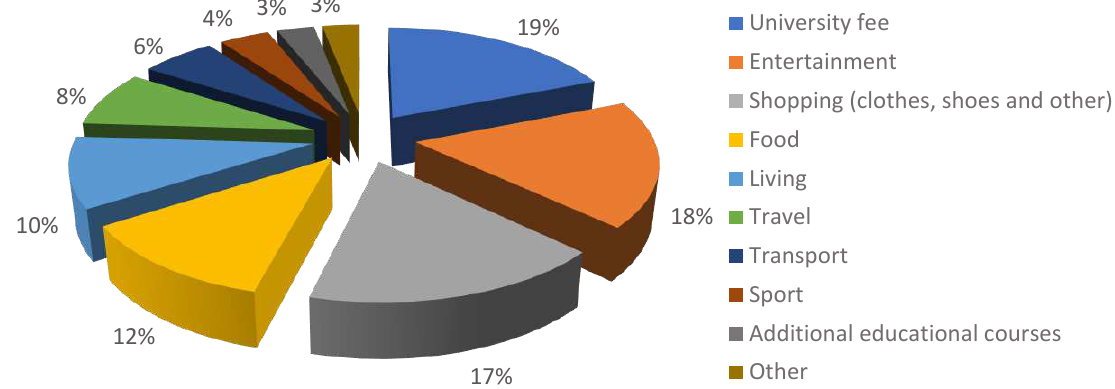
Figure 1. Grouping the respondents according to the